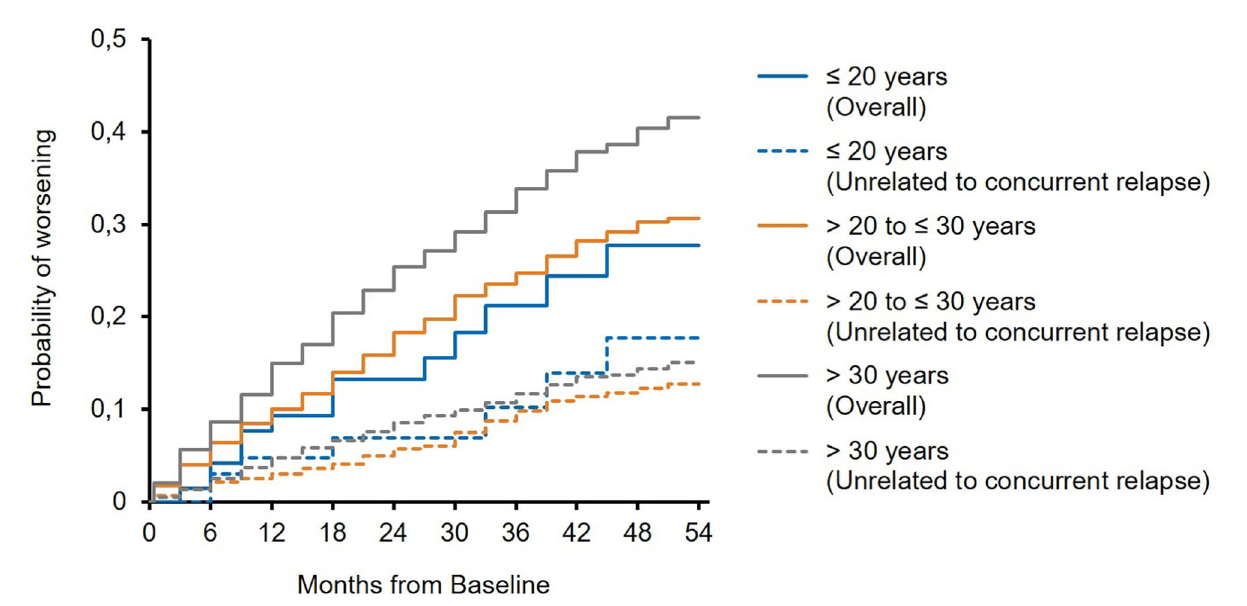
FIGURE 2 | Roving expanded disability status scale (EDSS) progression overall and unrelated to concurrent relapse (EDSS worsening is related to a relapse if at least one relapse occurred between 30 days before start of EDSS worsening and 30 days after confirmation of EDSS worsening).